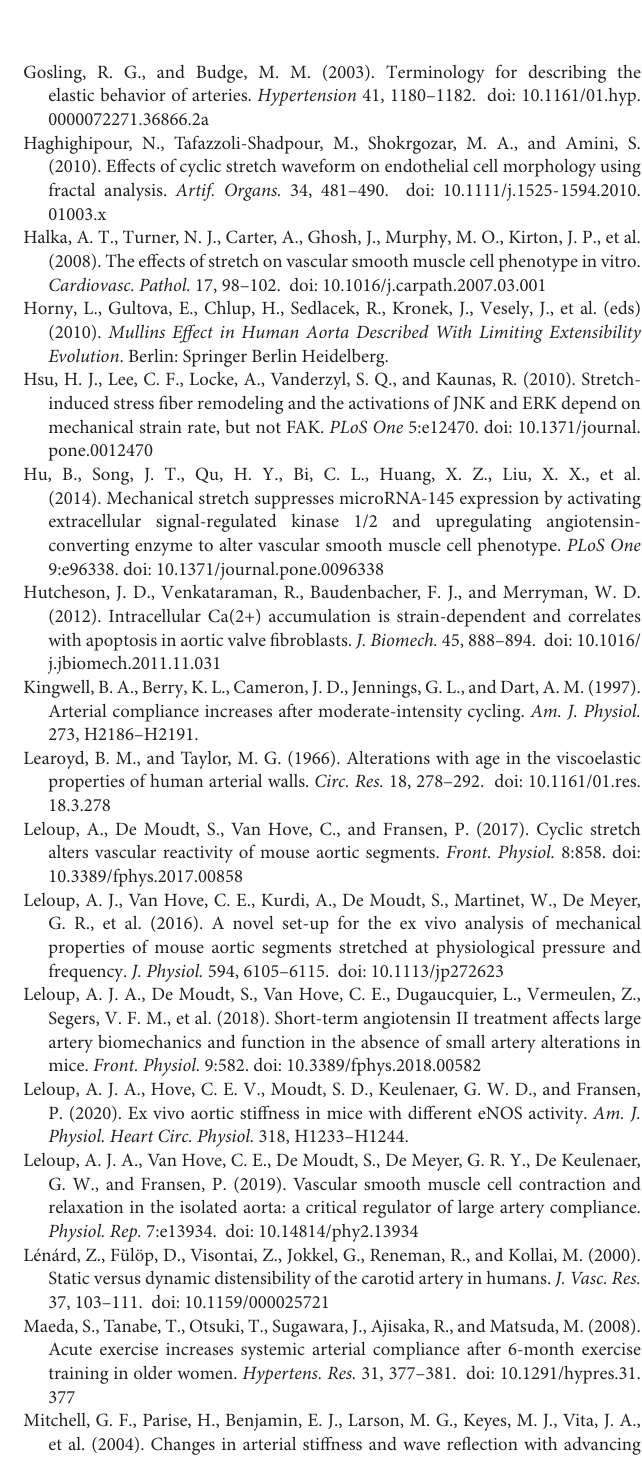
Supplementary Figure 3 | The effect of VSMC contraction and basal tonus on Ep per pulse pressure. The relationship between stiffness and pressure (Ep–Mean pressure) under contracting and relaxing conditions at a pulse pressure of (A) 20 mmHg, (B) 40 mmHg, (C) 60 mmHg, (D) 80 mmHg, and